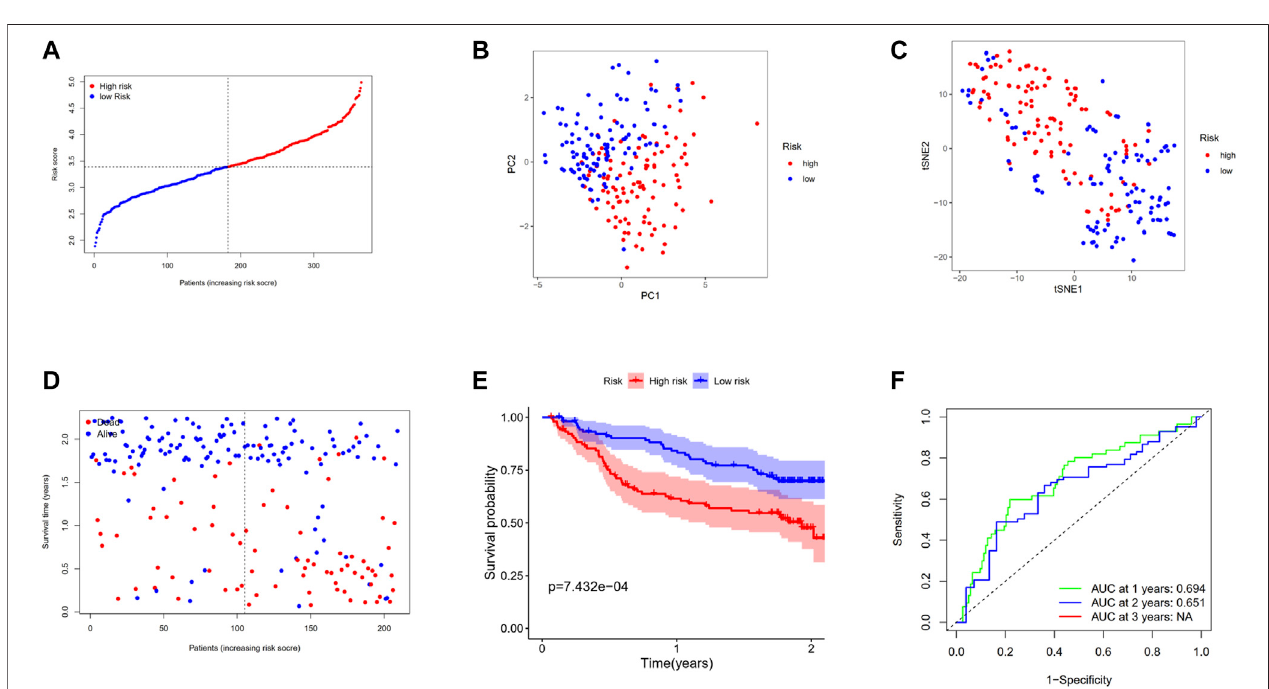
FIGURE7| Validationofthe12-genesignatureintheGSE14520 cohort. (A) Thedistributionand medianvalueoftheriskscoresintheGSE14520cohort. (B) PCA plot of the GSE14520 cohort. (C) t -SNE analysis of the GSE14520 cohort. (D) The distributions of OS status, OS, and risk score. (E) Kaplan – Meier curves for the OS of patients in the high-risk group and low-risk group. (F) AUC of time-dependent ROC curves in the GSE14520 cohort.